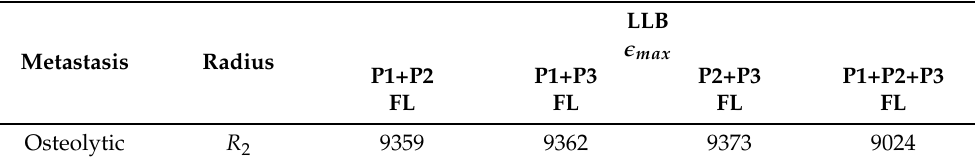
Table 2. The fracture load (FL) expressed in N is reported for the cases in which multiple osteolytic lesions are considered. Results are reported in left lateral bending loading condition and using the maximum principal strain